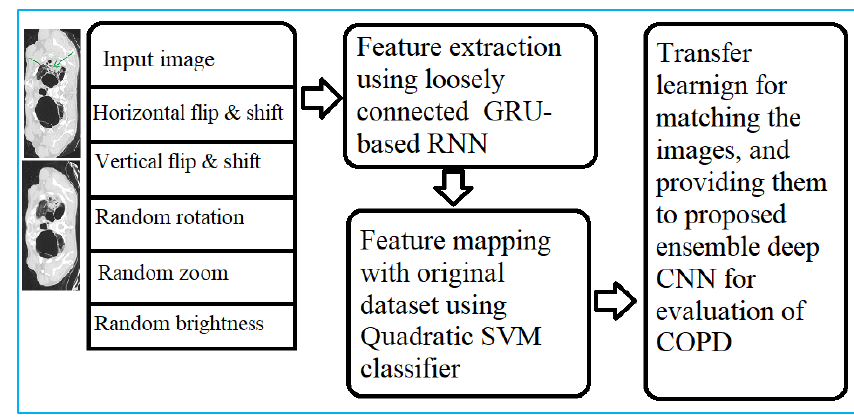
Figure 8. Data augmented transfer learning model for real time COPD classification.